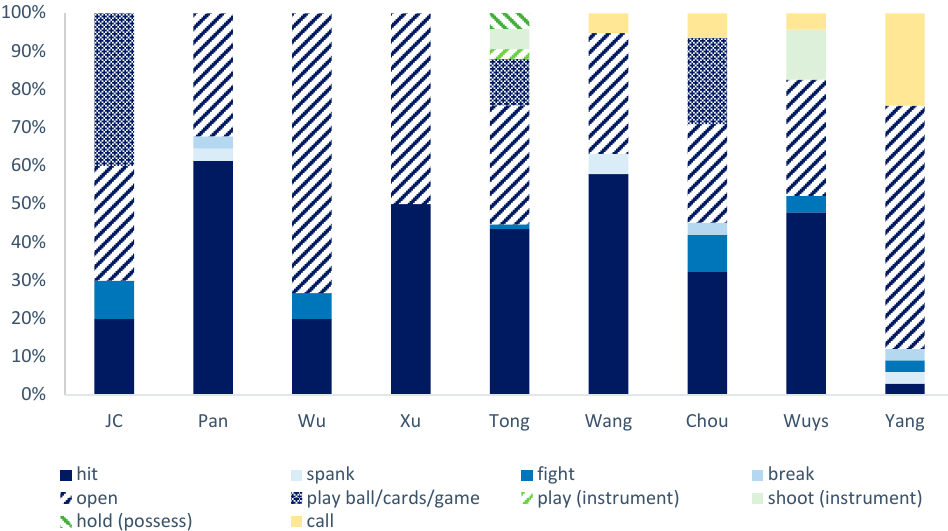
Figure 2. Proportions of different senses of 打 d ǎ by individual child 3 .